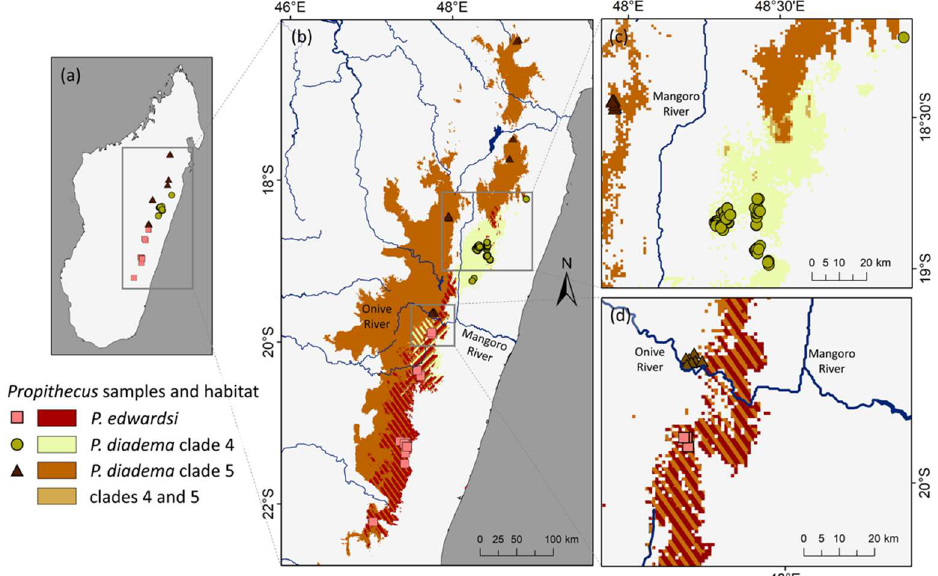
Figure 4. Ecological niche models for the two Propithecus diadema clades (4 and 5) as well as P. edwardsi . Habitat that is suitable to more than one clade is indicated with hashed lines with the color depicting each clade. ( a ) The samples used in this study. ( b ) The full niche models (not restricted to forest cover) for the three groups across eastern Madagascar. ( c ) Only the forest-limited models for P. diadema clades 4 and 5 and indicates a limited potential contact zone of niche overlap, despite the absence of a physical barrier between these taxa. ( d ) Only the forest-limited models for P. edwardsi and P. diadema clade 5, with suitable habitat for both species found on either side of the Onive River. Recorded occurrences of these taxa indicate that the Onive may act as a dispersal barrier, despite this potentially suitable habitat. The models in ( c , d ) are limited to forest cover in 2017, the most recent year available